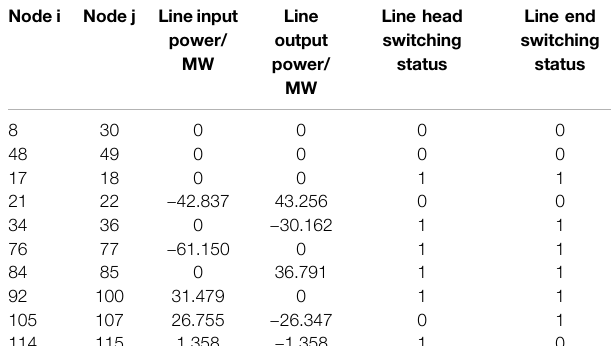
TABLE 1 | comparison of variables and